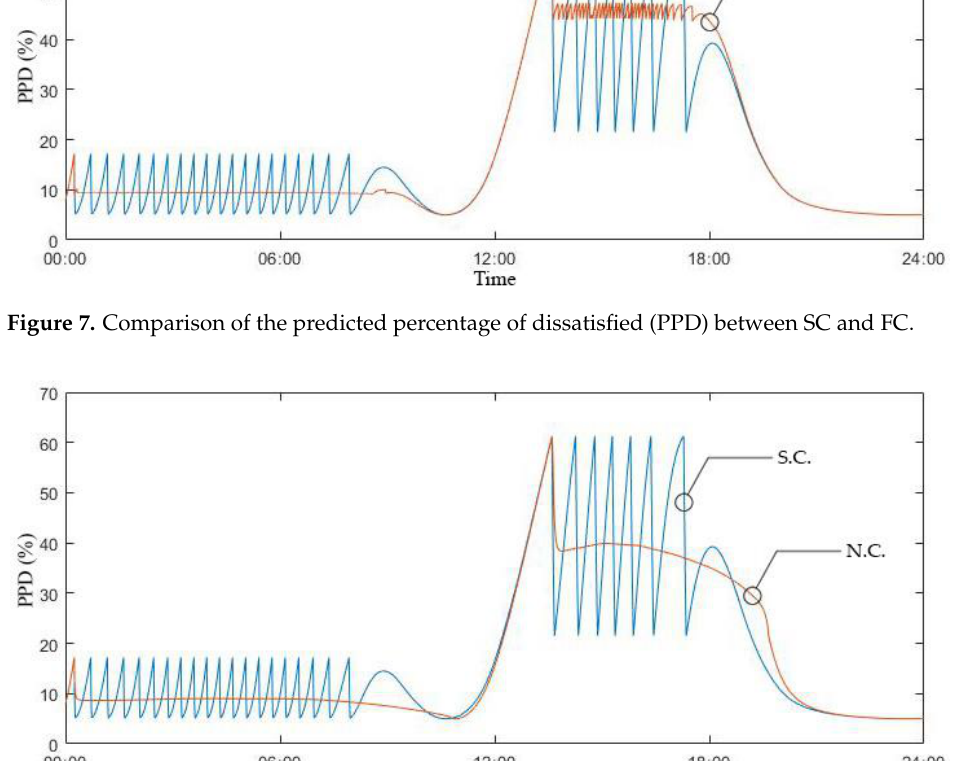
Figure 8. Comparison of the PPD between SC and NC.